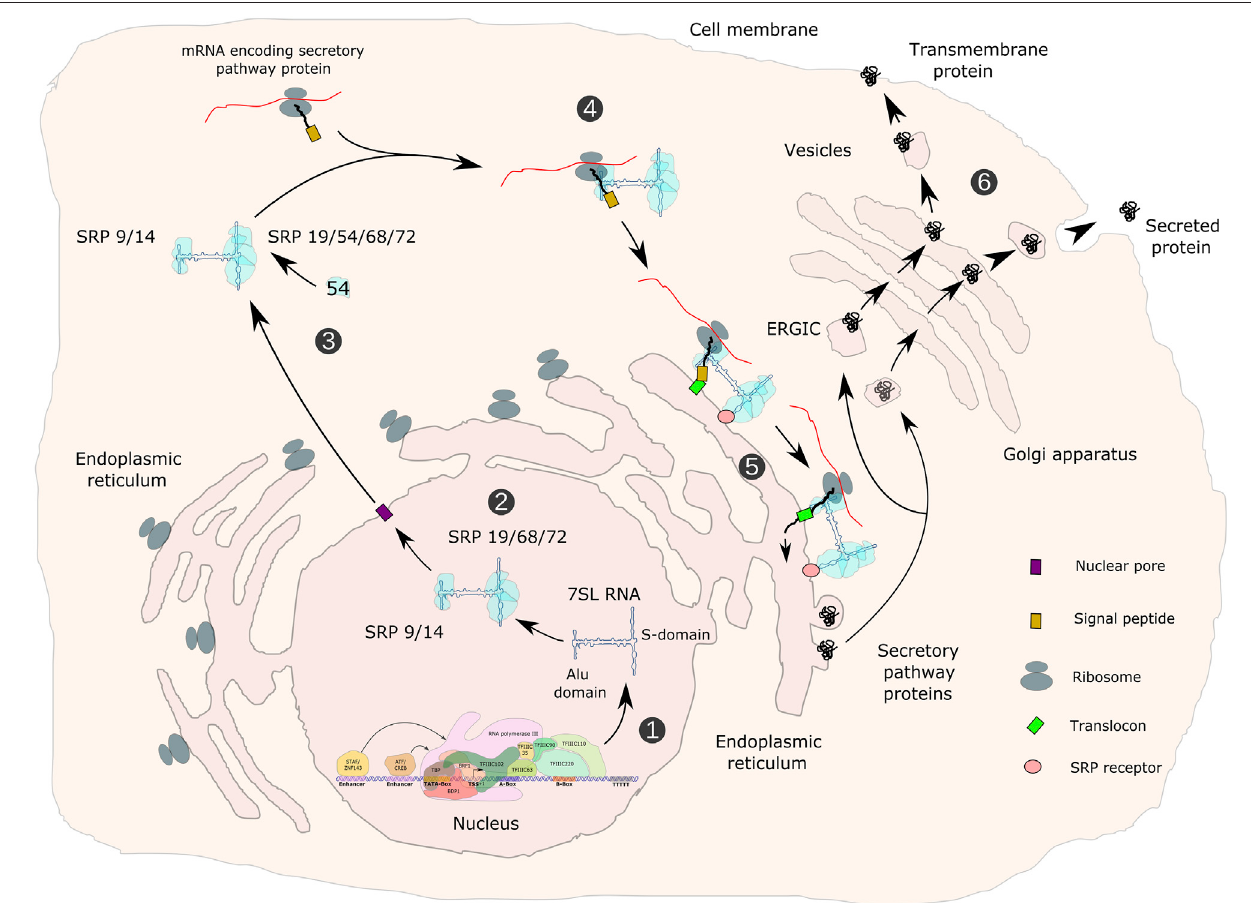
FIGURE8| Transcriptionofthe7SLRNAgene,assemblyofthesignalrecognitionparticleandfunctionsin thesecretorypathway.7SLRNAgenetranscription is directed by gene-internal A- and B-boxes as well as by an ATF/CREB-response element and a distal sequence element (DSE) upstream of the TSS. Transcription is initiated by TFIIIC- and TFIIIB- β -dependent recruitment of Pol III (1). The SRP 9/14/19/68/72 pre-signal recognition particle (pre-SRP) is assembled in the nucleus (2), exported to the cytoplasm and completed with SRP54 (3). SRP recognizes hydrophobic signal peptides in nascent polypeptide chains of secretory pathway proteins (4), arrests translation, translocates arrested ribosomes to the endoplasmic reticulum (ER), where translation resumes and proteins are translocated either into the lumen or into the membrane of the ER (5). Proteins of the secretory pathway are either incorporated into membranes or exported from cells (6). ERGIC refers to the ER-Golgi-intermediate